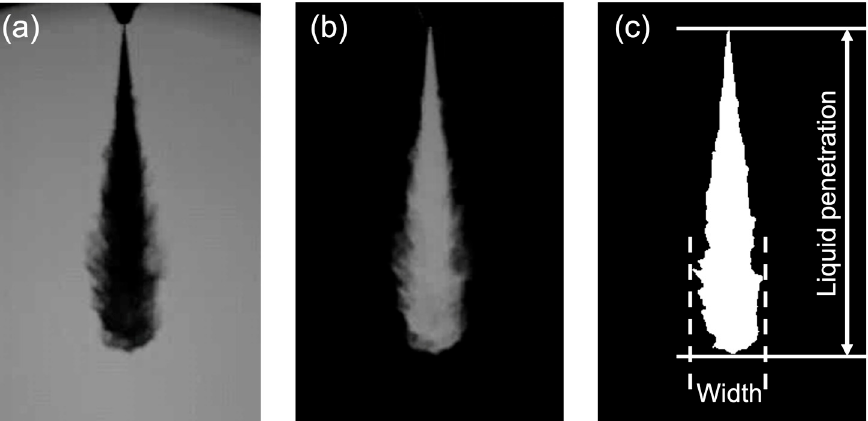
Figure 2. Image processing of sprays: ( a ) raw image, ( b ) black–white inversion and background subtraction, ( c ) binarization.